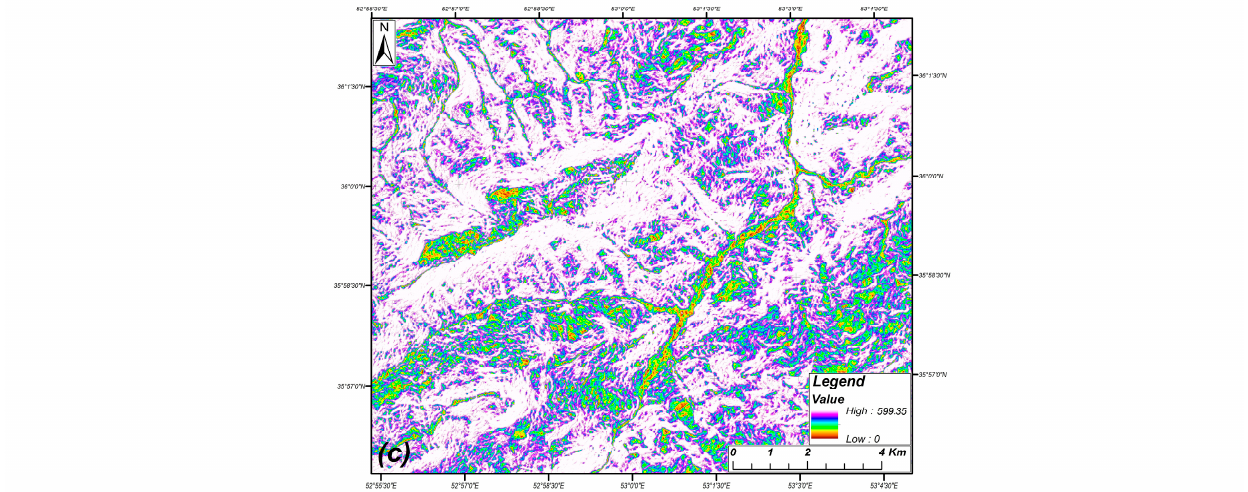
Figure 5. The water conditional triggering factors: ( a ) hydrological gradient, ( b ) drainage pattern, and ( c ) flow gradient.